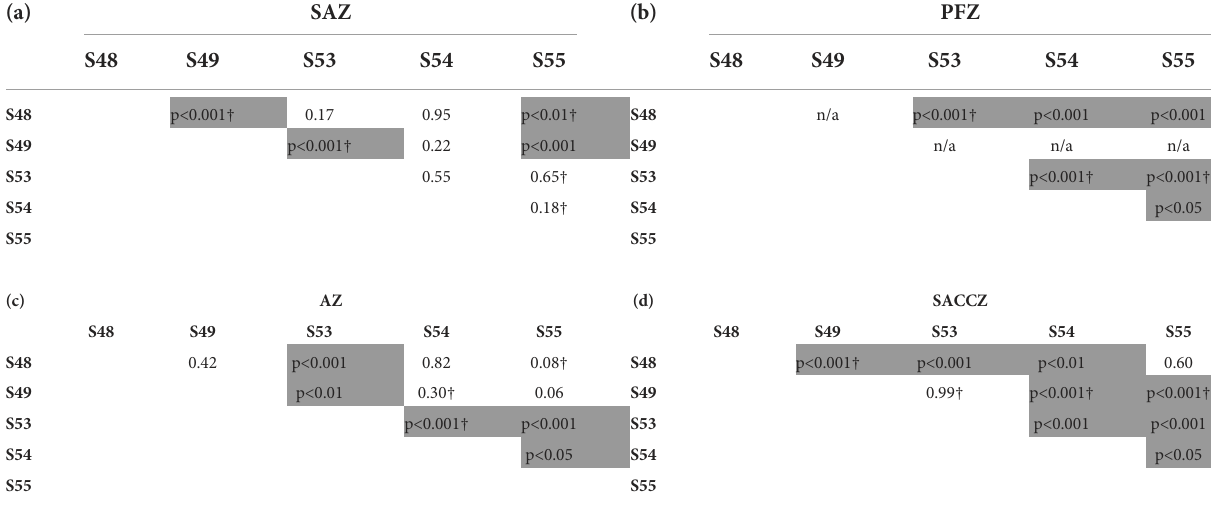
(Supplementary Table S5) compared to other zones (±0.003 - ±0.05), indicative of a higher range of inter-annual variability. In the AZ, inter-annual variability was particularly low with the